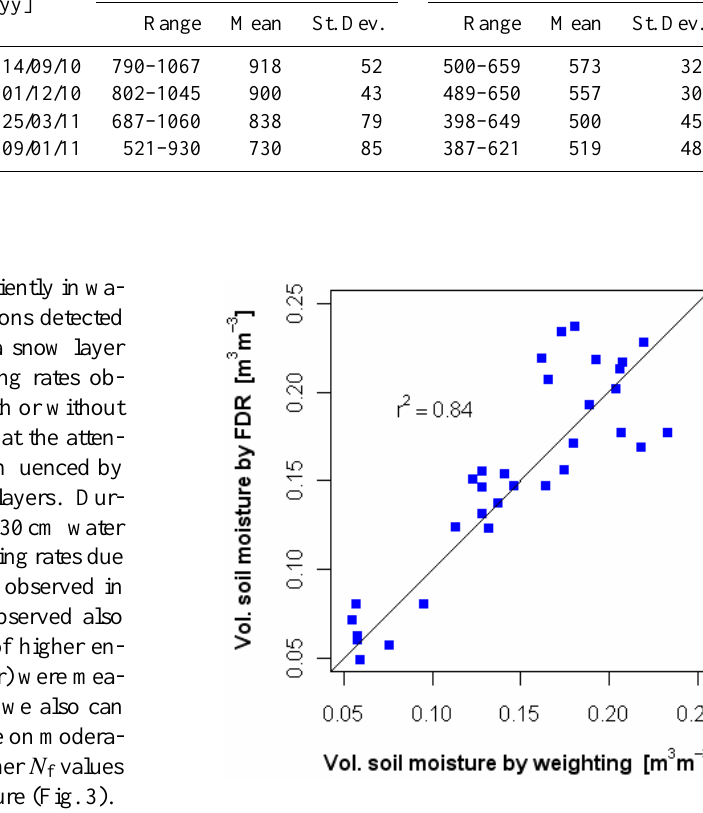
Fig. 4. Calibration of Theta Probes (MR2): observed soil moisture Figure 4. Calibration of Theta Probes (MR2): observed soil moisture from soil cores and 2 from soil cores and soil moisture measured by soil moisture measured by MR2s. 3